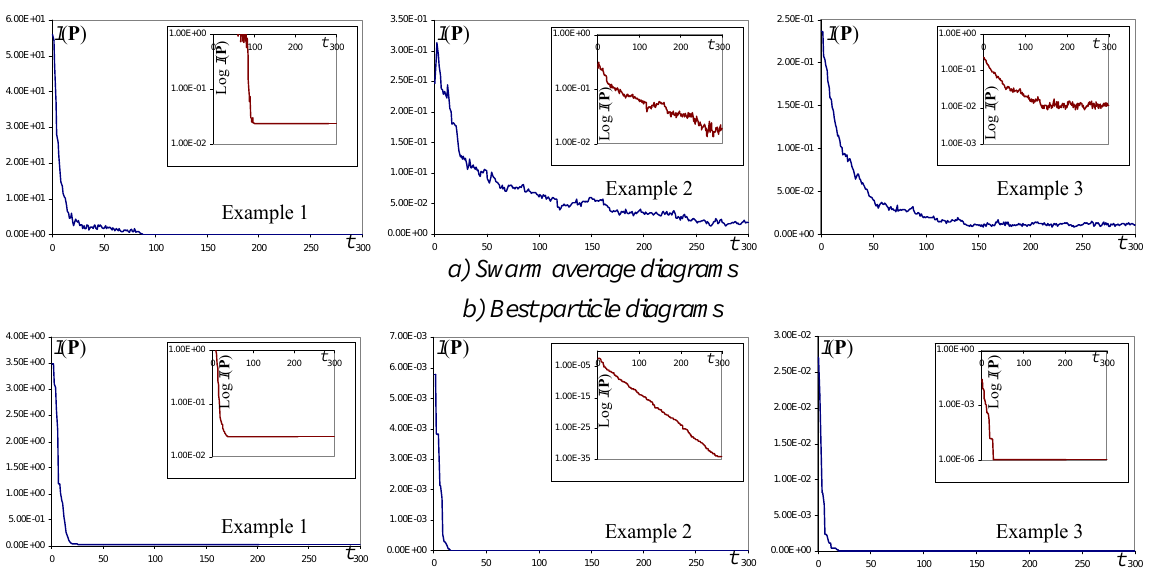
Figure 8. Convergence diagrams of I ( P ) for the three examples (in small, the diagrams in